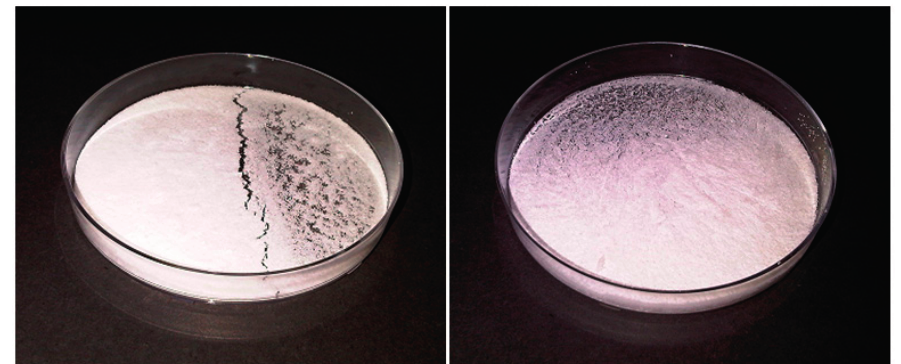
Figure 2. Digital images of PCL nanocapsule formulations post lyophilization.